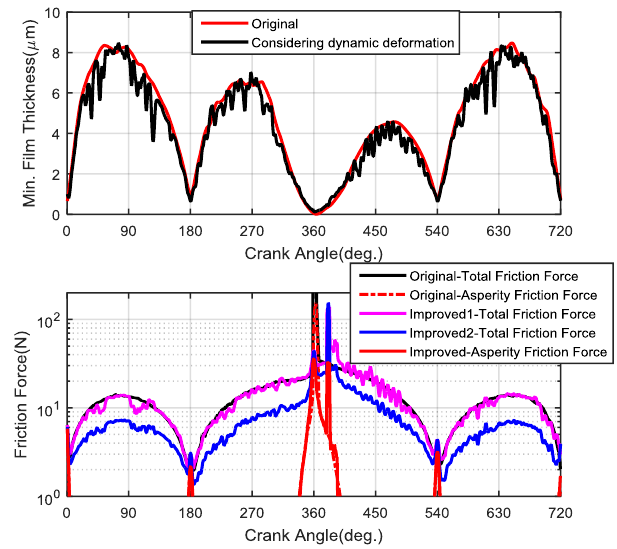
Figure 12. Comparison of H m and friction forces based on two improved models and original models.